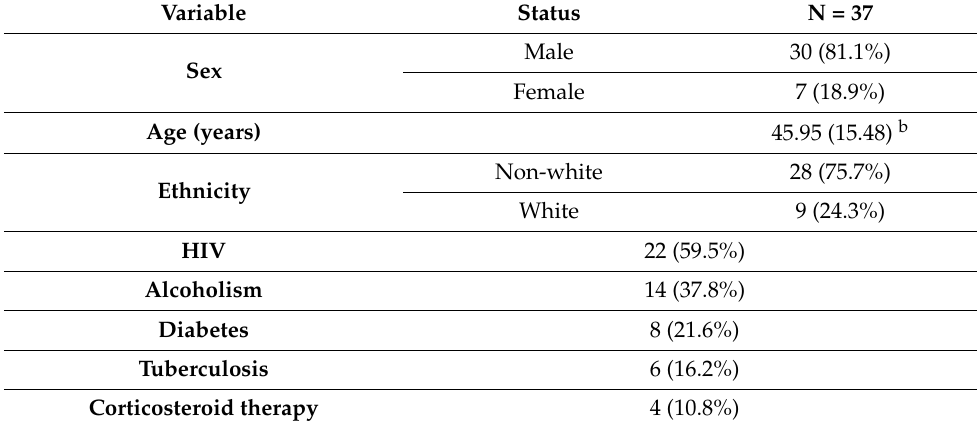
Table 1. Clinical, epidemiological, and follow-up data of 37 patients with sporotrichosis treated